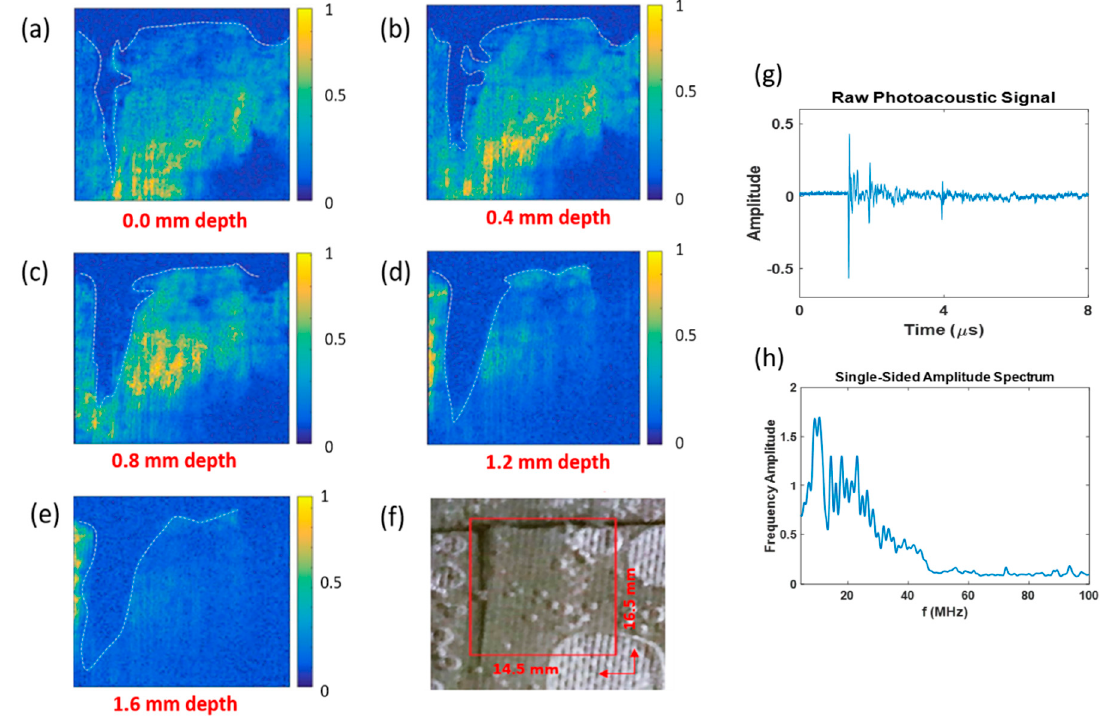
Figure 6. A pulsed laser-induced pNDE system to detect macro-scale delamination and transverse ply cracks in composites. ( a – e ) The 2D C-scan images showing the size of delamination and transverse ply cracking. ( f ) Optical images using the detected impact damage of composites. ( g ) A plot of the raw photoacoustic signal. ( h ) Single-sided photoacoustic signal frequency amplitude spectrum plot.